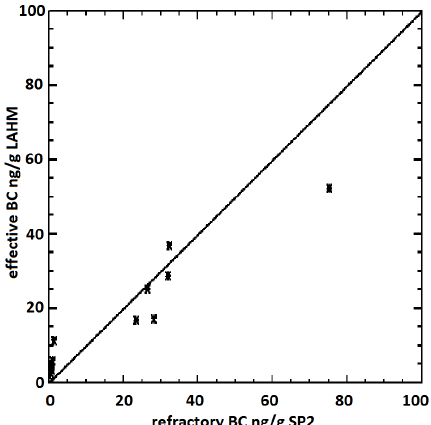
Figure 5. Plot showing the relationship between eBC as determined from the LAHM analysis and refractory black carbon as determined by the SP2 instrument ( r 2 = 0 . 92). The values near 0.0 refractory BC are from Pisco mountain in region 2 while the higher values are from Vallunaraju in region 4. The 1 to 1 line is plotted to guide the